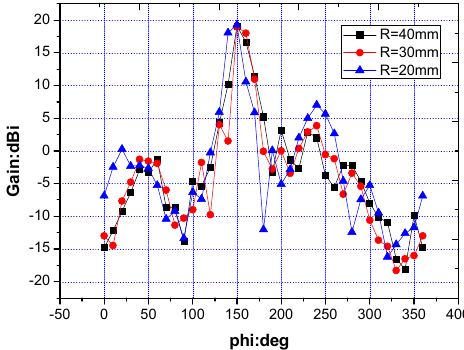
Figure 10. Gain pattern with different parabolic surface radii. at 59 GHz.